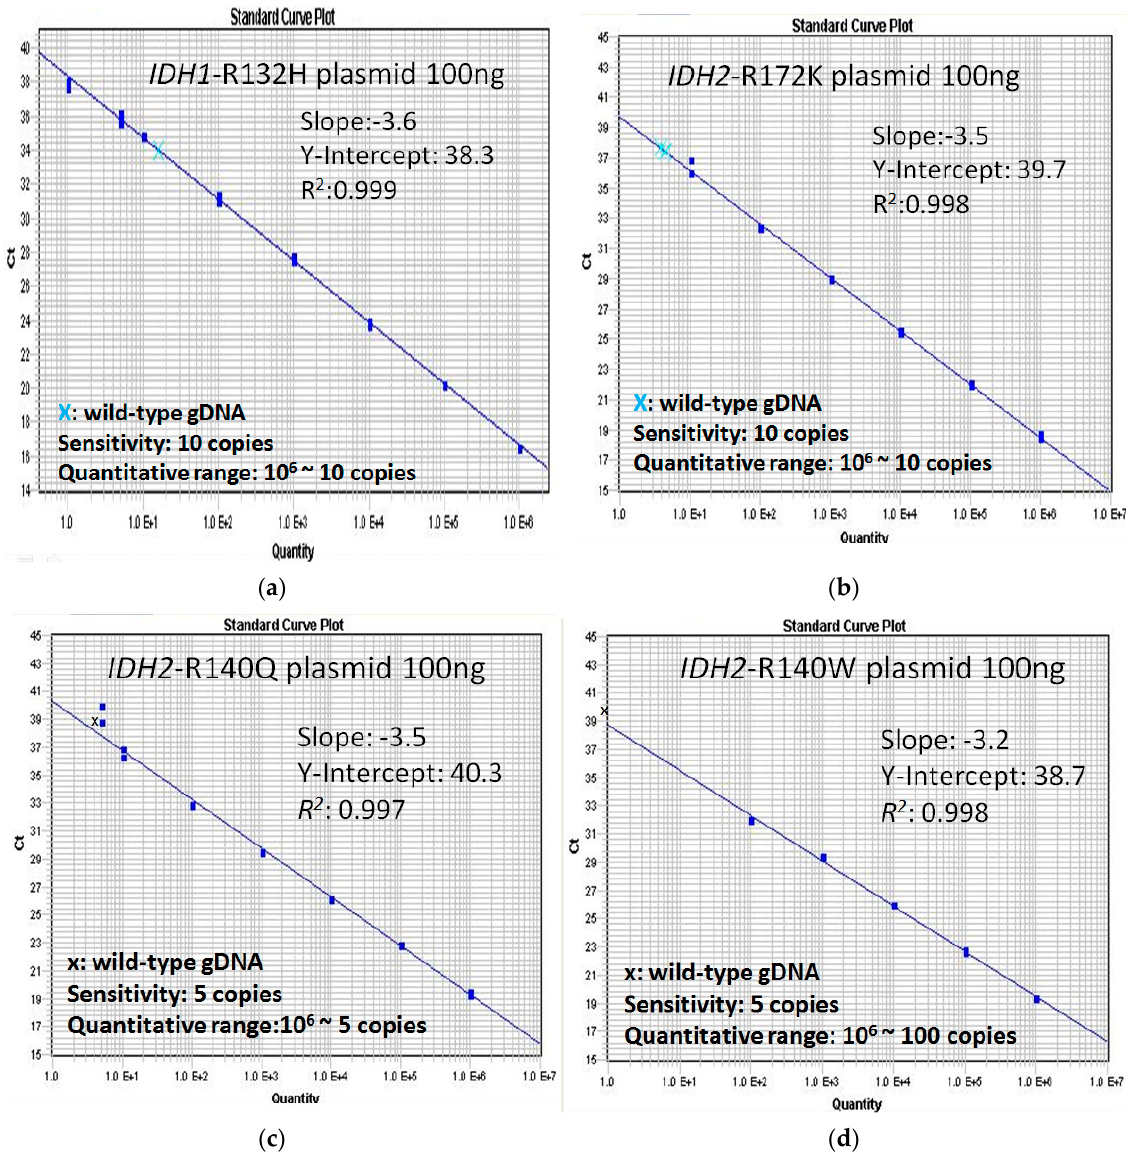
Figure 1. Standard curves constructed by IDH1/2 mutant plasmids. ( a ) IDH1 ‐ R132H. ( b ) IDH2 ‐ R172K. ( c ) IDH2 ‐ R140Q. ( d ) IDH2 ‐ R140W. ( c ) IDH2 -R140Q. ( d ) IDH2